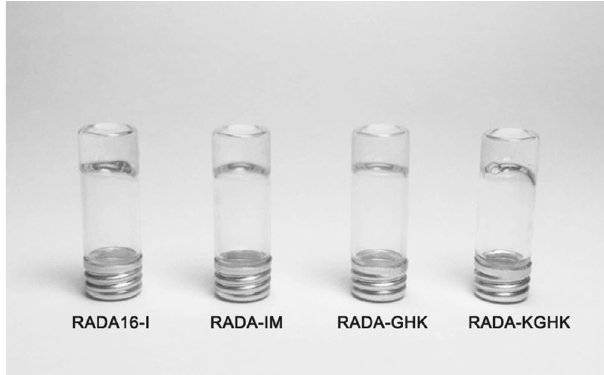
Figure 8. Images of RADA peptide hybrids after the gelling process.